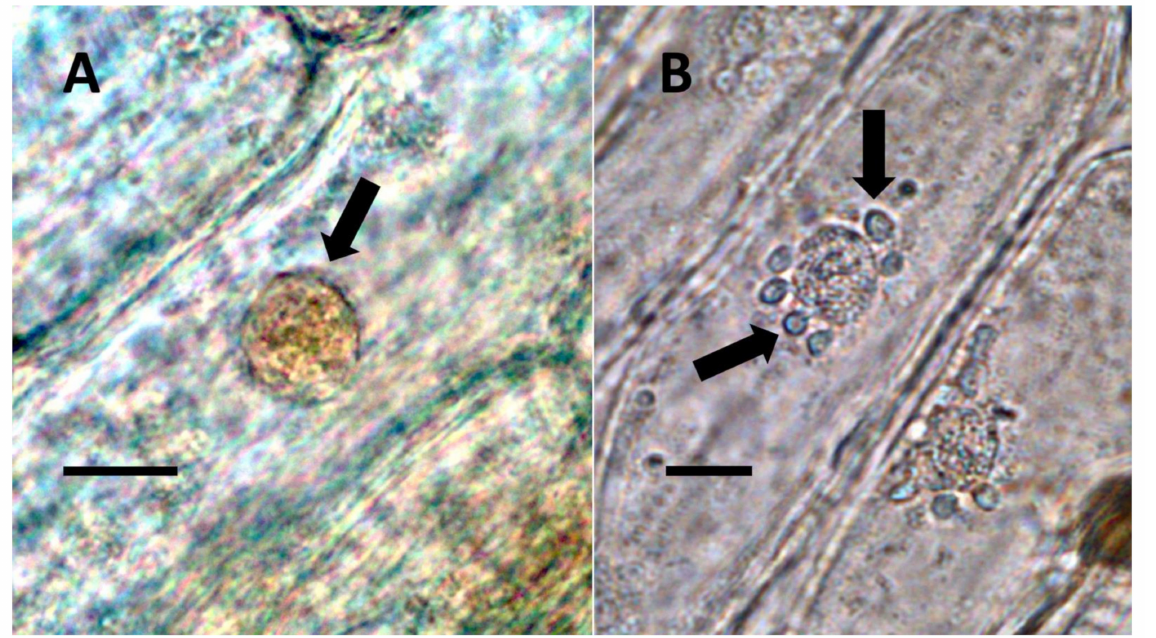
Figure 1. Nuclei showing internal bacteria (arrows). ( A ) Festuca rubra nucleus (arrow) stained for reducing sugars (orange color in nucleus) using copper sulfate (Bar = 10 µ m). ( B ) Hosta plantaginea nuclei stained with acidified diphenylamine to show nitrate (blue-purple color) as bacteria exit the nucleus (Bar = 10 µ m).